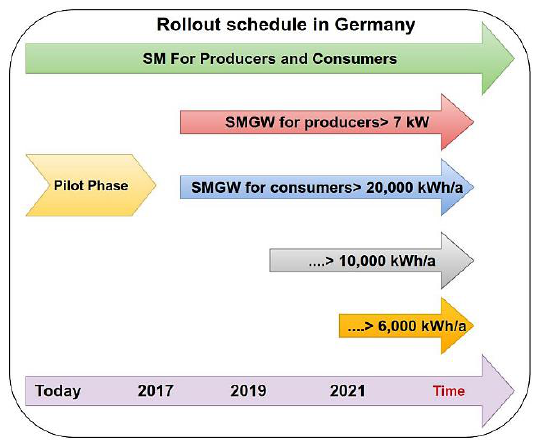
Figure 2. SMGW Rollout